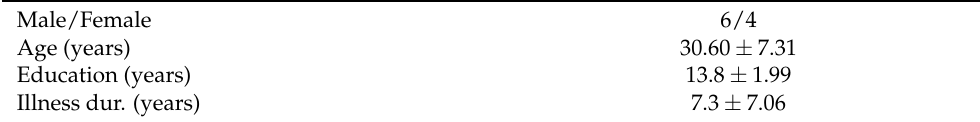
Table 5. Demographics